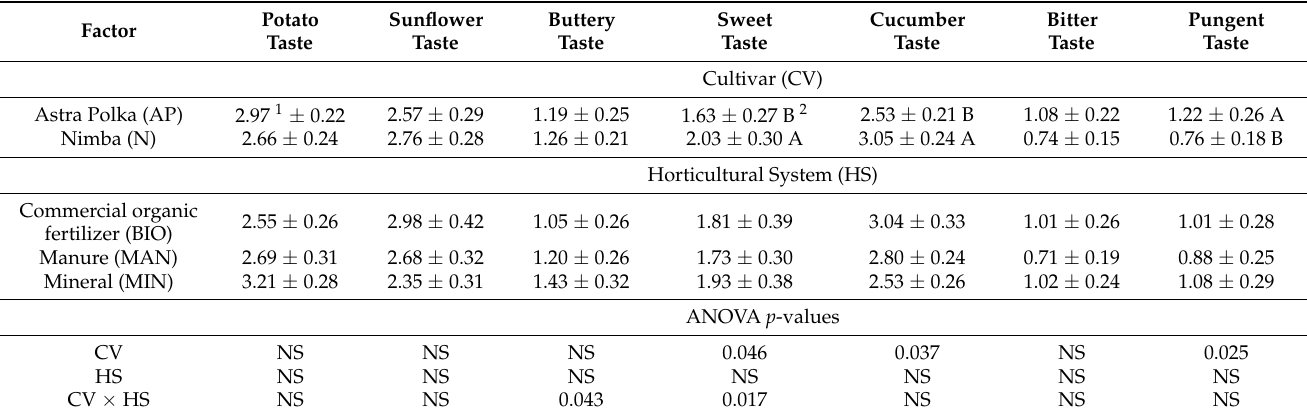
Table 7. The main effect of, and interactions between, cultivar and horticultural system on the taste attributes of cour- gette